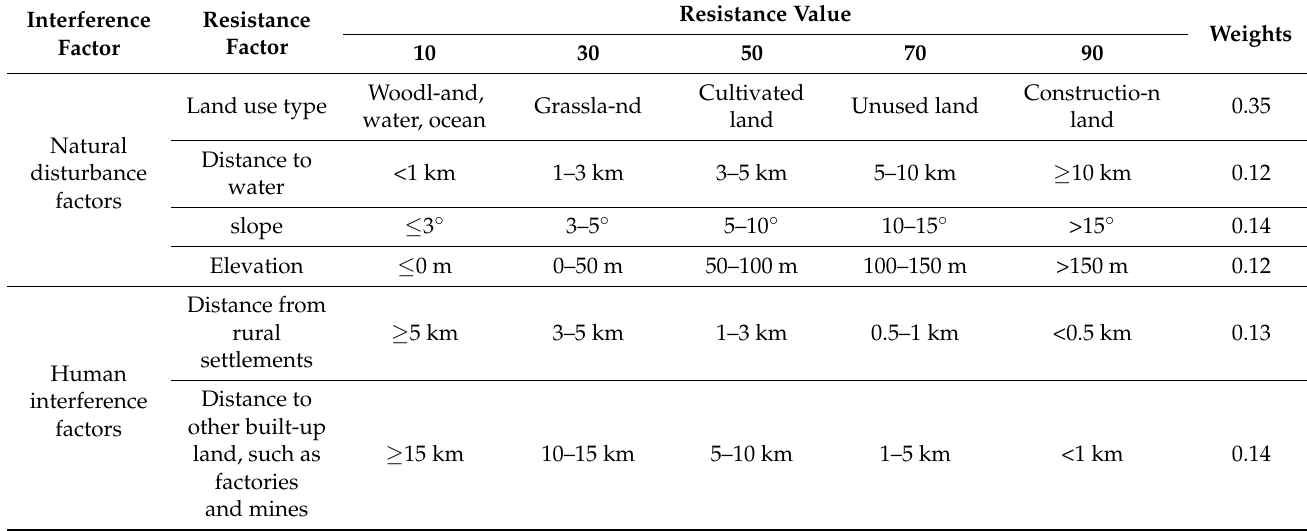
Table 1. Resistance